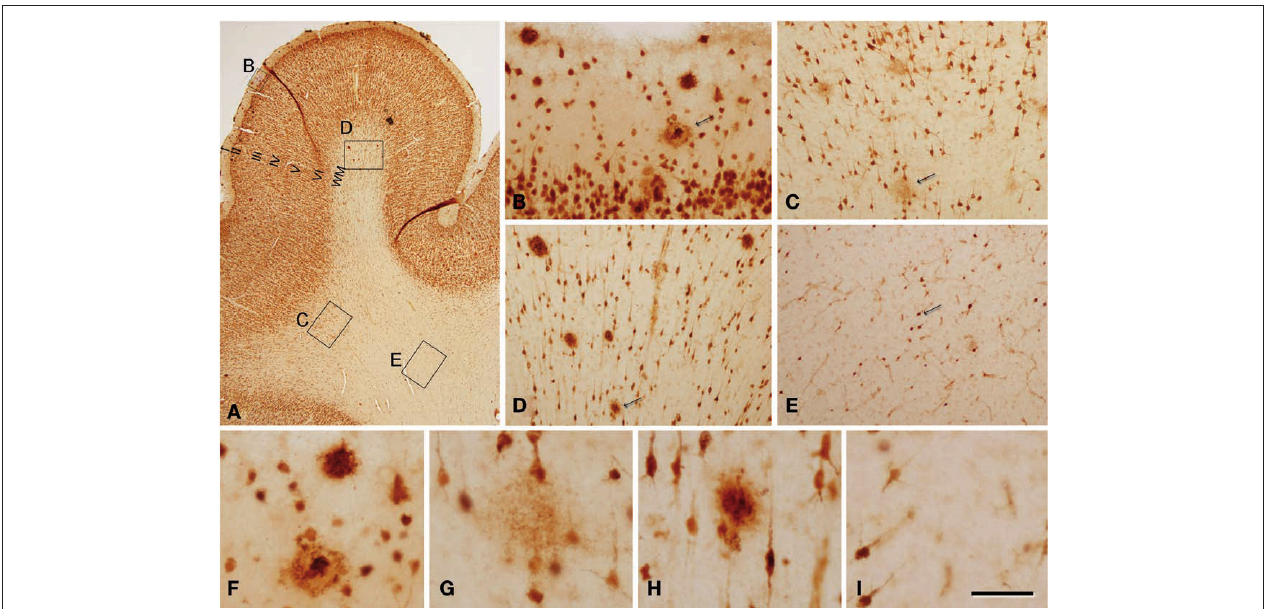
FIGURE 2 | Photomicrographs from a section double stained for anti-A β and NeuN, showing the pattern of immunostaining in layer I and in the white matter of the temporal cortex of patient P2. (A) Panoramic view showing the cortical layers and white matter. (B,F) Low- and high-magnifi cation of layer I, illustrating a non-cored neuritic and a cored neuritic plaque. (C,G) , (D,H) , and (E,I) are low- and high-magnifi cations of the boxed areas in the white